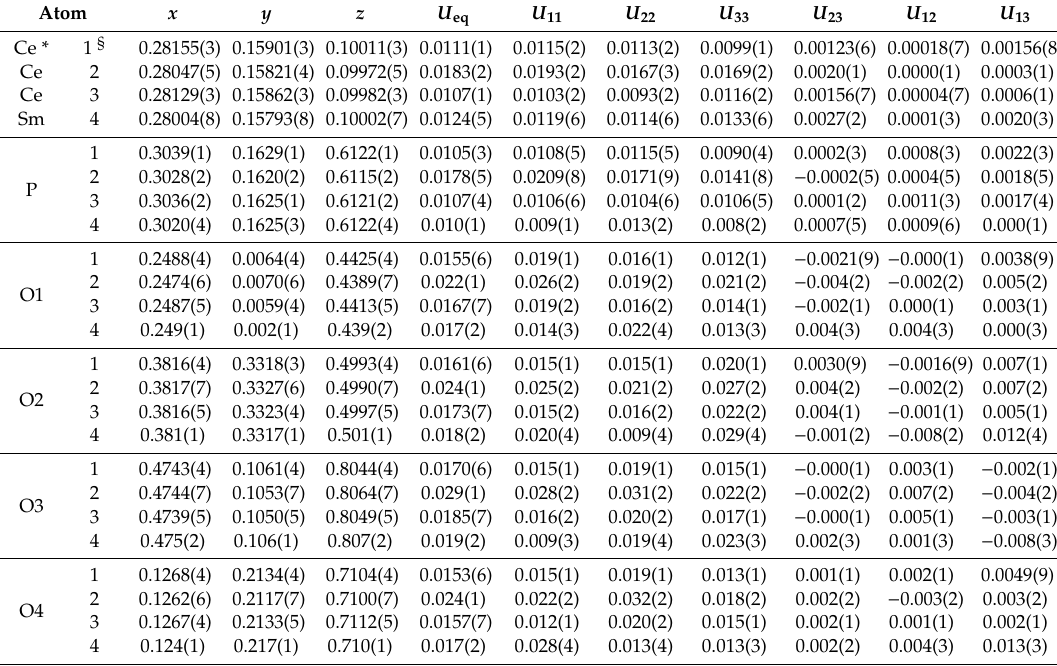
Table 4. Site occupancy factors ( sofs ), atom coordinates, and anisotropic displacement parameters ( U eq , U ij ; Å 2 ) for the four monazite samples.